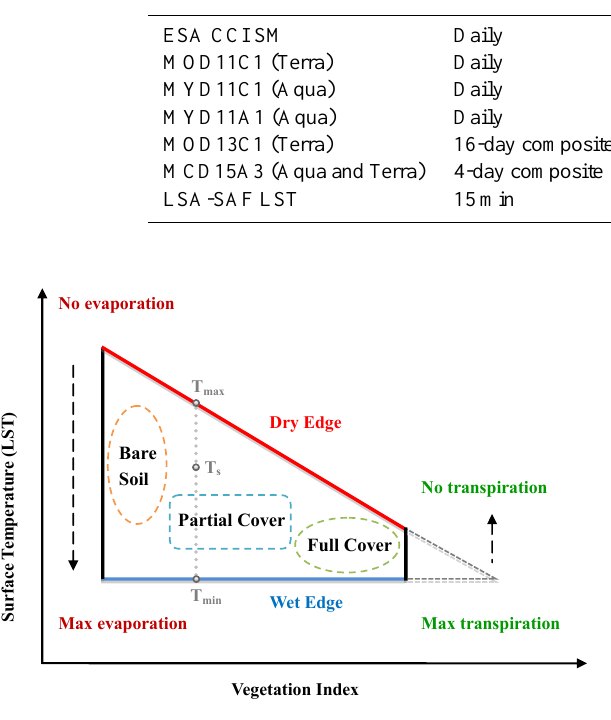
Figure 2. Conceptual diagram of the triangular/trapezoidal feature space that is constructed by land surface temperature and vegetation